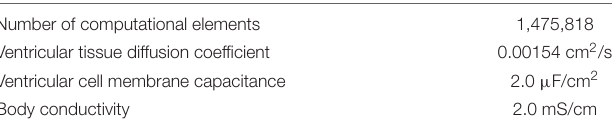
TABLE 1 | Key parameters of simulation.